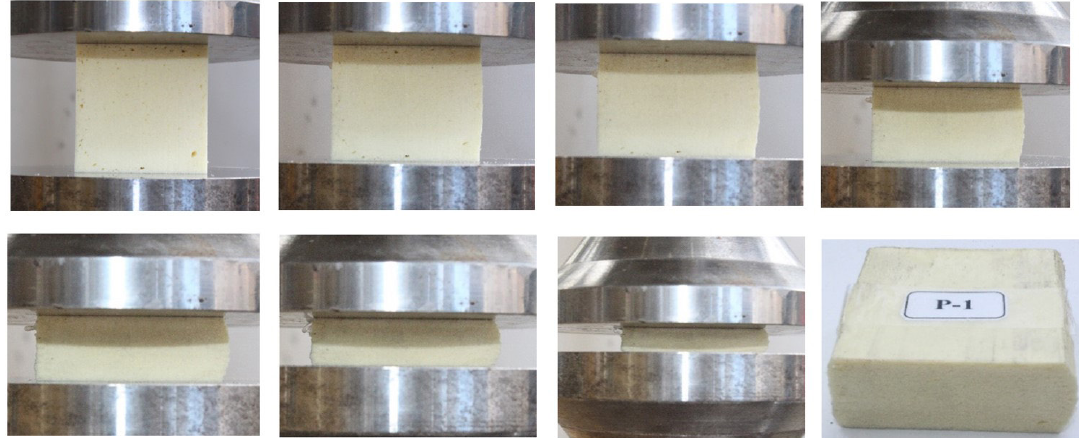
Figure 6. Stages of the failure mode of polyurethane foam laterally crushed.